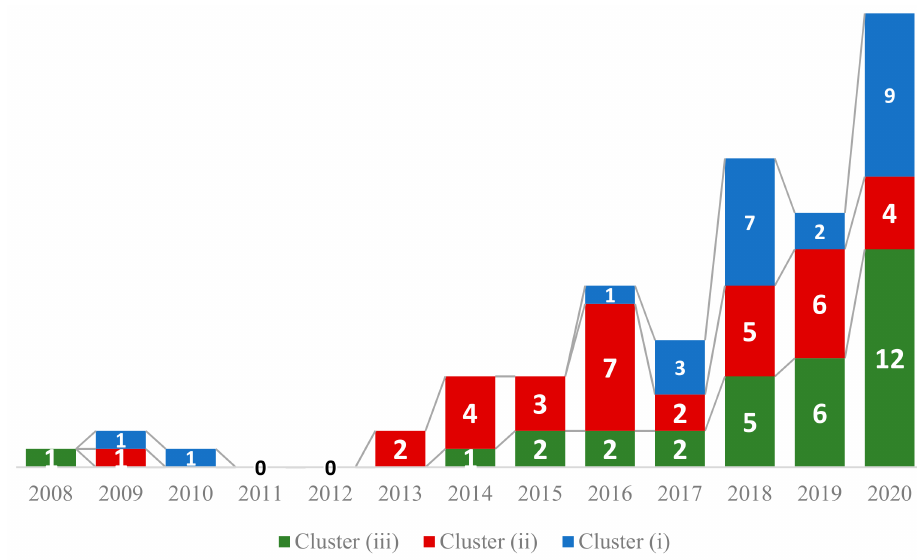
Figure 12. Evolution of the number of publications by identified predominant